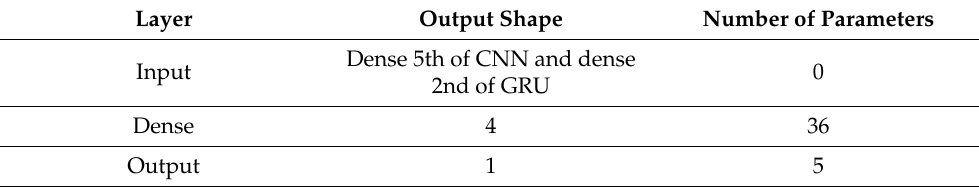
Table A3. Details of the CNN + GRU architecture considering both feet (12